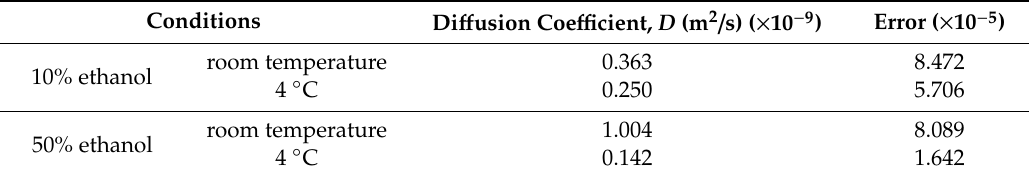
Table 6. Di ff usion coe ffi cient of isopropyl palmitate determined using the late-time approximation of Fick’s second law of di ff